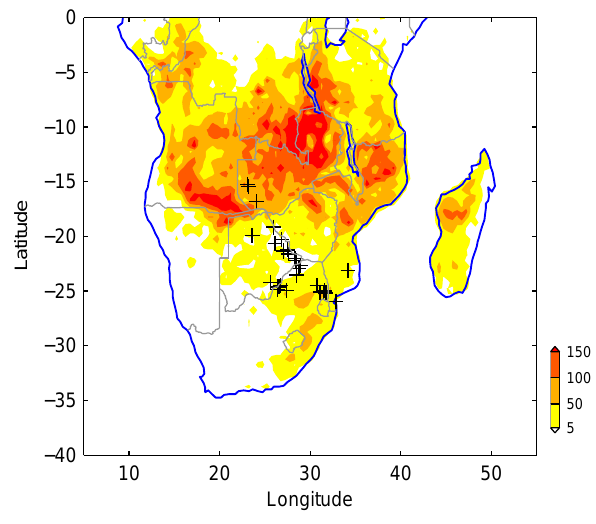
Fig. 1. Locations of filter samples collected during the SAFARI- 2000 field campaign (black crosses) and used in this study. Colors are mean (2001–2007) August and September fire counts derived from Moderate Resolution Imaging Spectroradiometer (MODIS) measurements (Collection 5) in units of fires per half degree gridcell.